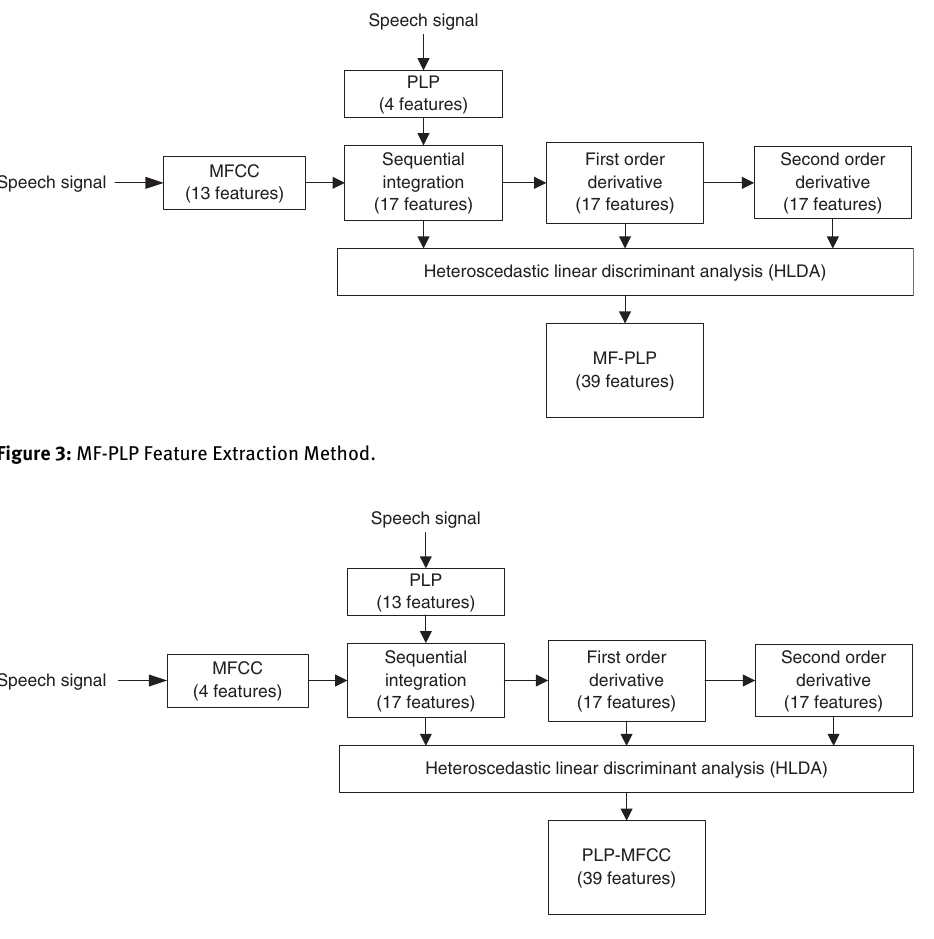
Figure 4: PLP-MFCC Feature Extraction